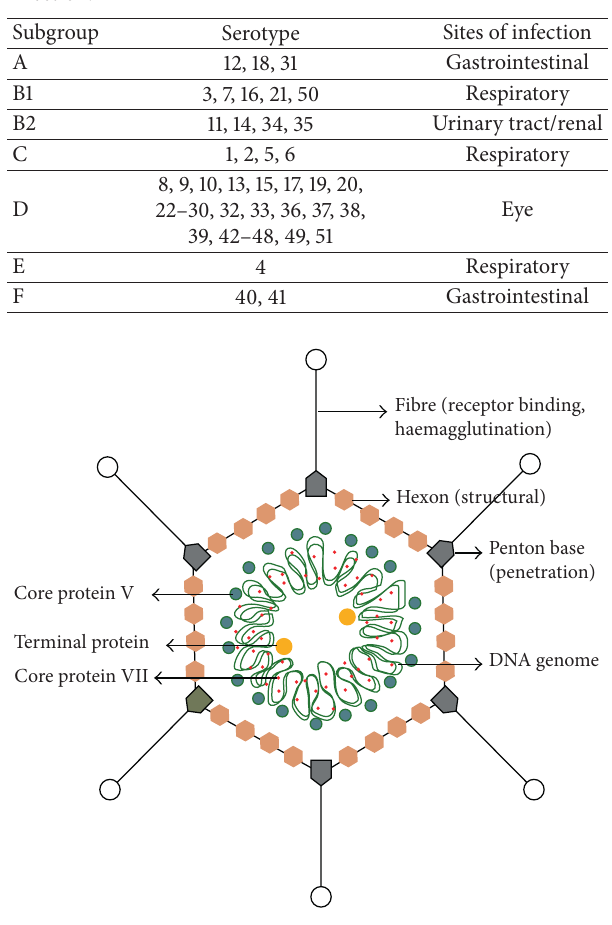
Table 1: Classification of human adenoviruses and their sites of infection.